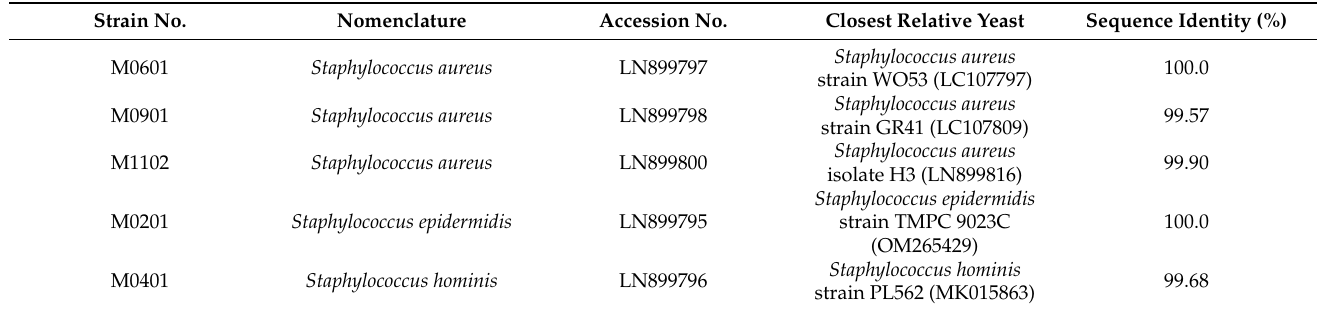
Table 1. Molecular identification of oral cavity bacterial species based on GeneBank BLAST